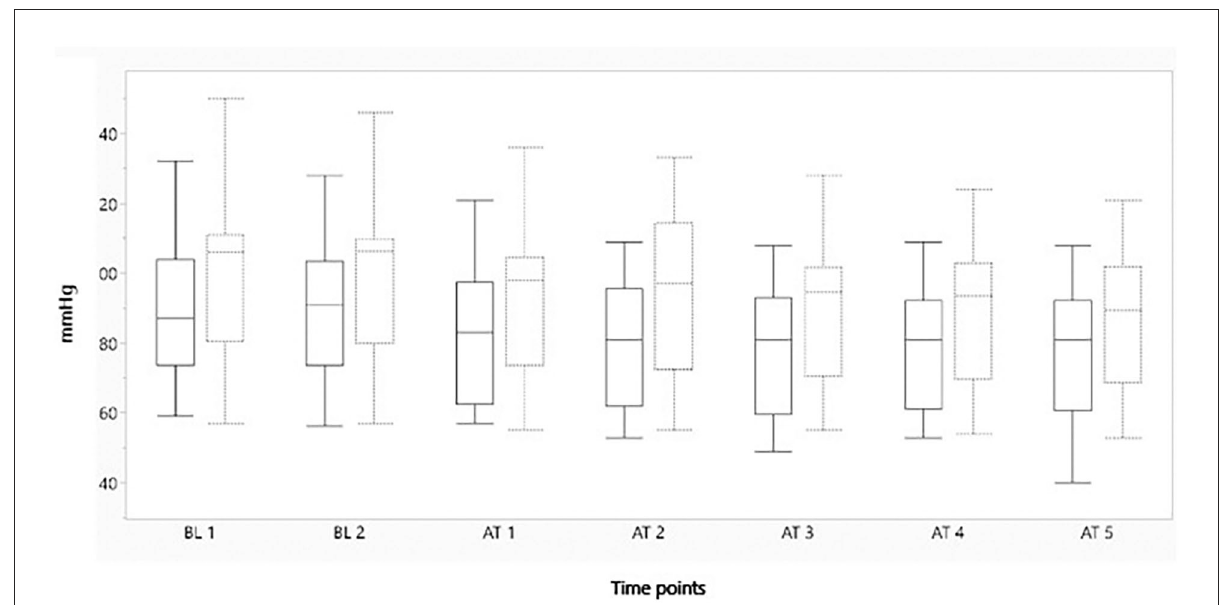
FIGURE2 Boxplot showing minimum mean arterial blood pressure (mmHg) on the y-axis, before and after administration of either morphine or NaCl IV. The x-axis represents two baseline measurements with 1min interval and five measurements after administration with 1min interval. The solid line represents the morphine group and the staple line the placebo group. Boxplot characteristics: upper line = maximum value, excluding outliers, upper line of box = Q3 (75th percentile); middle line in box = median: lower line in box = Q1 (25th percentile) lower line = minimum value excluding outliers. AT, after treatment; BT, baseline. 1–5 = minutes before or after